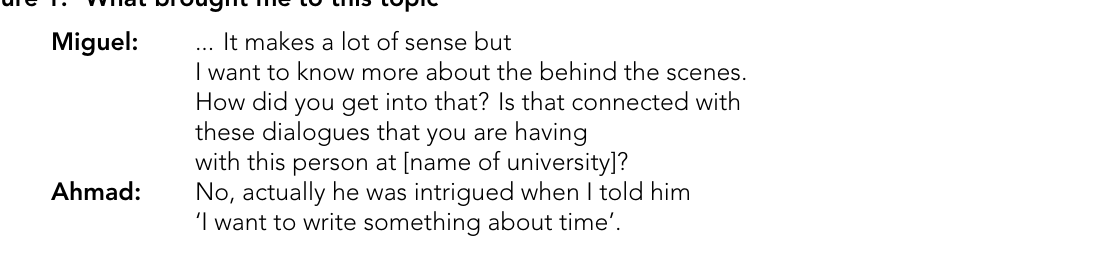
Figure 1. ‘What brought me to this